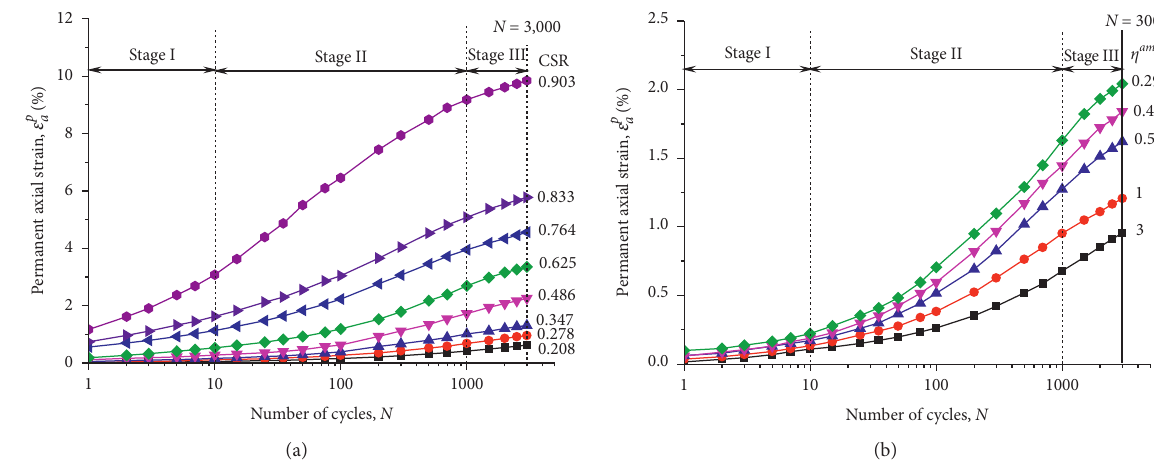
Figure 7: Relationships between permanent axial strains and cycle numbers: (a) η ampl � 3; (b) CSR �